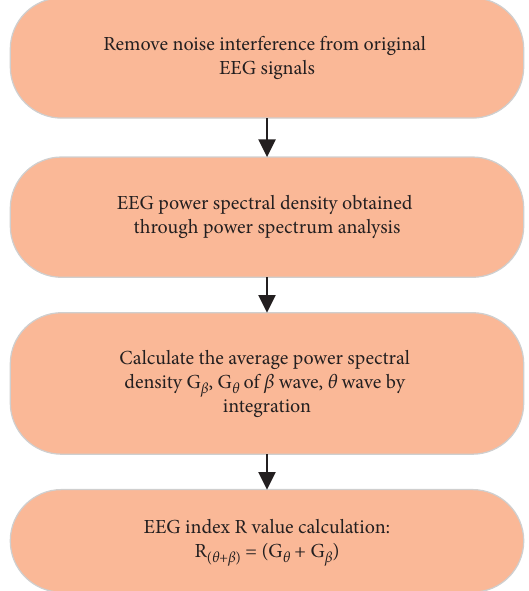
Figure 4: EEG index extraction